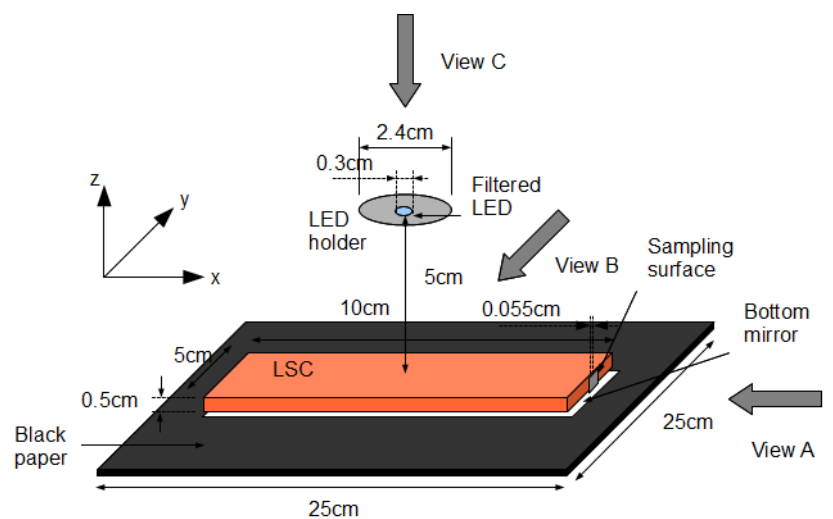
Figure 14. Ray-tracing simulation